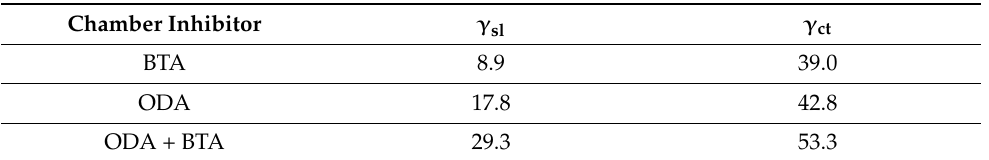
Table 6. Degrees of protection by CIN provided by the blocking and activation mechanisms for different variants of steel St3 chamber treatment.